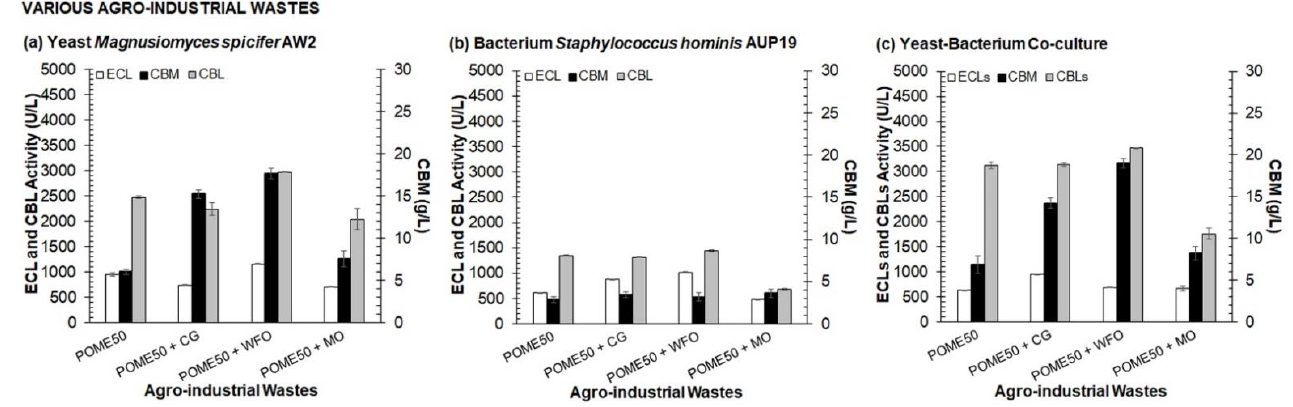
Figure 1. Selection of medium composition by one variable at a time (OVAT) for CBLs production in various agro-industrial wastes, including 50% POME (POME50), POME50 + 2.0% ( v / v ) crude glycerol (CG), POME50 + 2.0% ( v / v ) waste frying oil (WFO), POME50 + 2.0% ( v / v ) molasses (MO) by pure M. spicifer AW2 ( a ), pure S. hominis AUP19 ( b ), and co-culture M. spicifer AW2 + S. hominis AUP19 ( c ) at room temperature (30 ± 2 °C), with shaking at 150 rpm for 24 h.